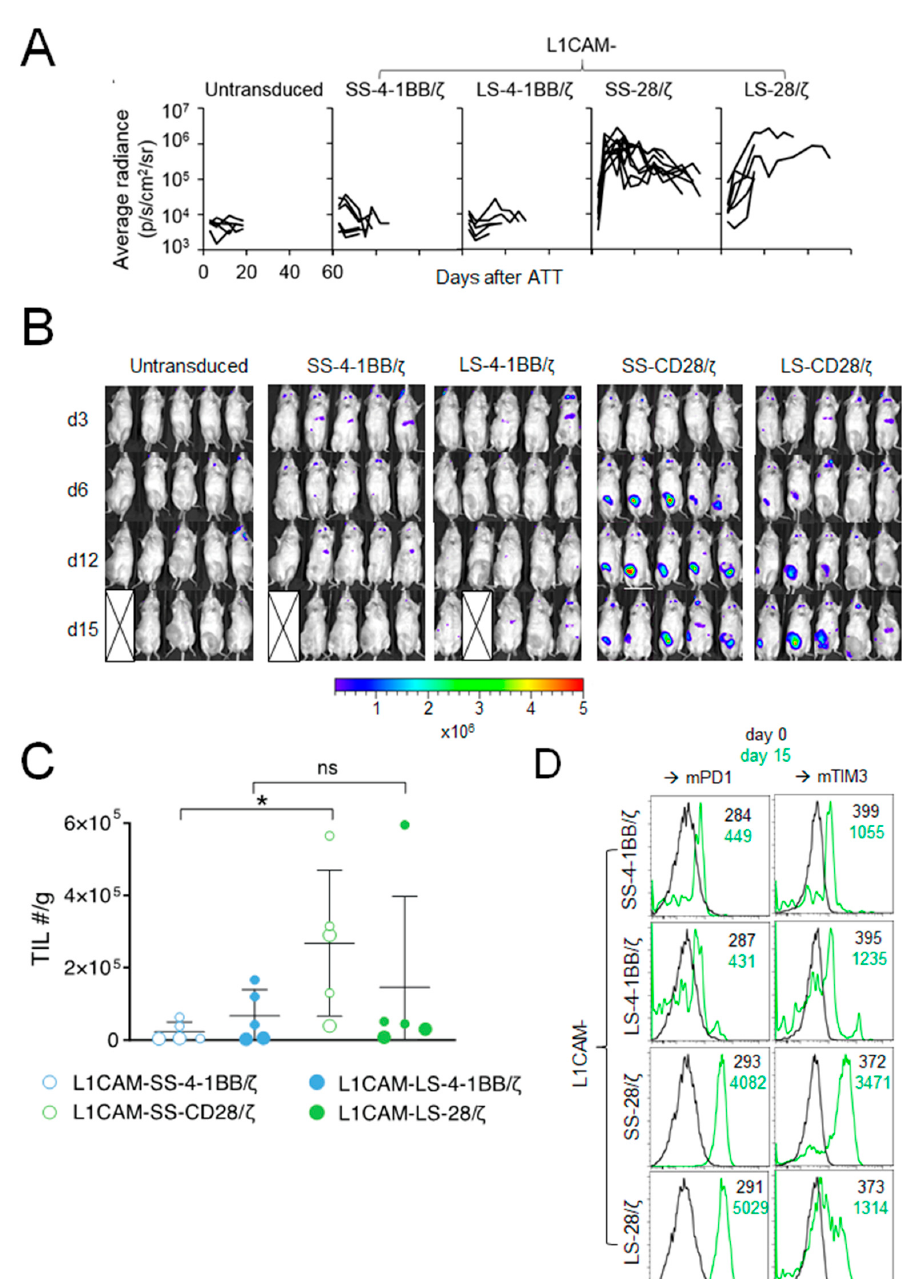
Figure 2. The CD28 signaling domain enables L1CAM-specific CAR T cells with short and long spacer to expand at the tumor site. ( A ) Kinetic of the T cell signal (average radiance) detected at the tumor site over time is shown for mice from Figure 1C (L1CAM-SS-4-1BB/ ζ ( n = 6), L1CAM-LS-4-1BB/ ζ ( n = 5), L1CAM-SS-28/ ζ ( n = 9), L1CAM-LS-28/ ζ ( n = 6), untransduced ( n = 5)). ( B ) Bioluminescent imaging data of mice shown in ( A ) on indicated time points following treatment (5 representative mice are shown for each group). The pseudo color scale indicates the intensity of the signal and is set from minimum 2 × 10 5 to maximum 5 × 10 6 p/s/cm 2 /sr. Data are representative of two independently performed experiments. ( C ) Mice were treated as described in ( A ) and were sacrificed on day 15. Tumors were harvested, T cells extracted and quantified. Total numbers (#) of TILs/g of tumors are depicted. Larger circles represent TILs of mice analyzed in ( D ). ( D ) TILs isolated from two mice of each treatment group shown in ( C ) were analyzed by flow cytometry for Pd1 + and Tim3 + expression and expression levels were compared to CAR T cells before infusion (d0). Black and green numbers within the graphs present mean fluorescent intensity (MFI) values of T cells before infusion and TILs isolated on day 15, respectively. Error bars represent SD, ns = not statistically significant *, p ≤ 0.05; TIL = tumor infiltrating